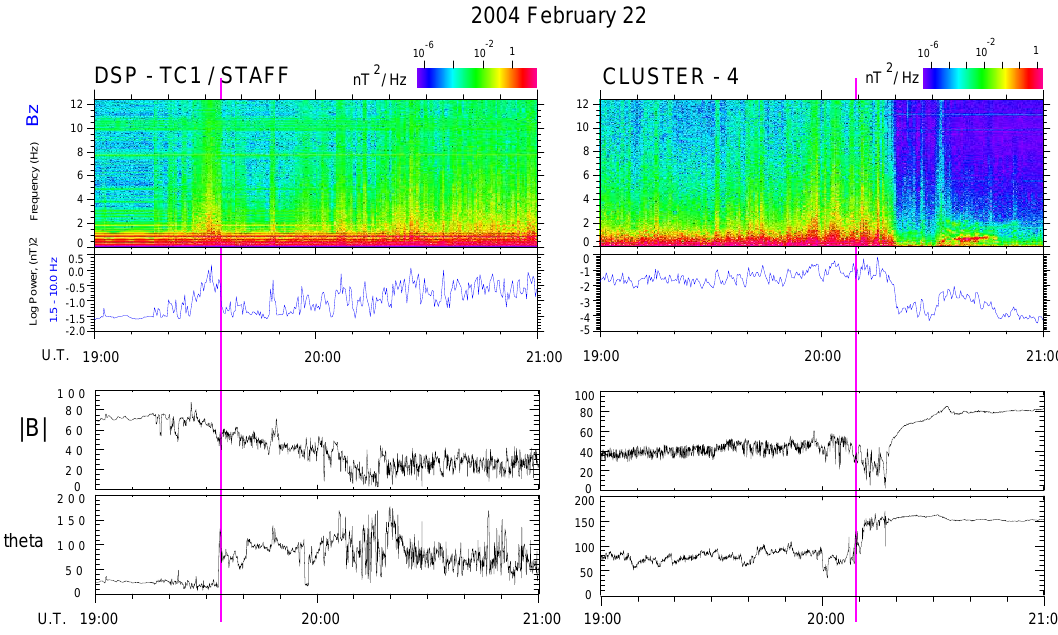
Fig. 9. Magnetopause crossing by DSP and Cluster during their outbound and inbound pass, respectively, on 22 February 2004, indicated by a violet line. STAFF dynamic spectra data are shown in the top panel, below which are plotted the integrated spectra. At the bottom, in order to evidence the crossings, the modulus and elevation of the magnetic field from the FGM PPD are plotted (see Fig. 10 for the orbits).